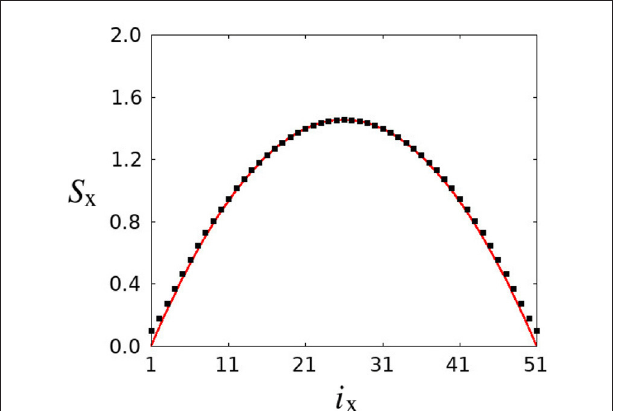
FIGURE A7 | Shear force variation across the width of the mid-section of a 51 × 51 × 409 square beam, with parabola expression included for comparison shown in red.